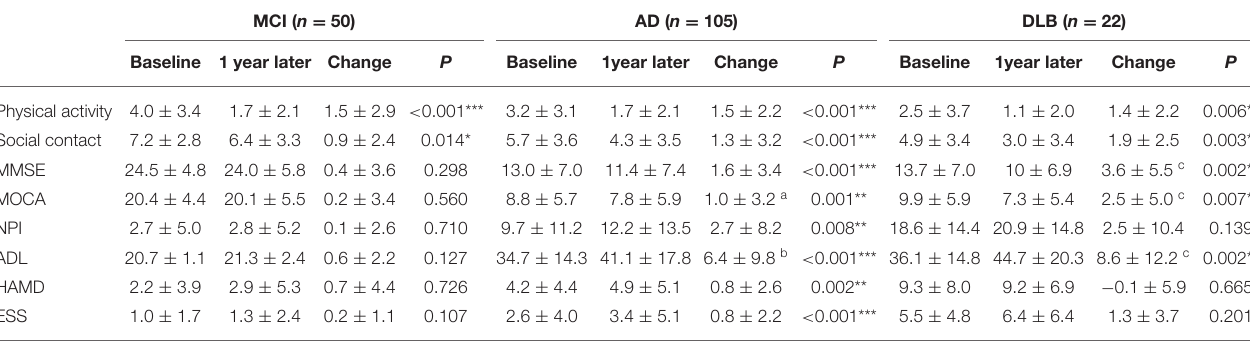
TABLE 2 | Comparison of baseline and 1-year follow-up data for patients with mild cognitive impairment (MCI), Alzheimer’s disease (AD) and probable dementia with Lewy bodies (DLB). MCI ( n = 50) AD ( n = 105) DLB ( n = 22) Baseline 1 year later Change P Baseline 1year later Change P Baseline 1year later Change P Physical activity 4.0 ±